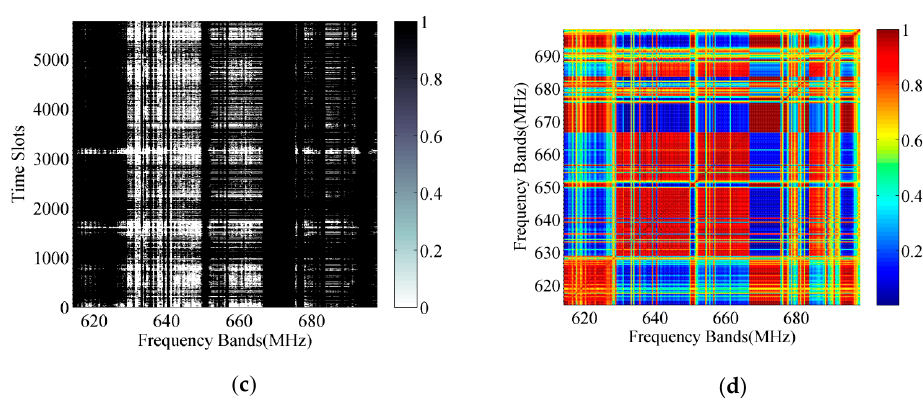
Figure 3. Channel occupancy and channel correlation distribution. ( a ) NE GSM1800 DL channel occupancy distribution. ( b ) NE GSM1800 DL channel correlation distribution. ( c ) NE TV channel occupancy distribution. ( d ) NE TV channel correlation distribution.